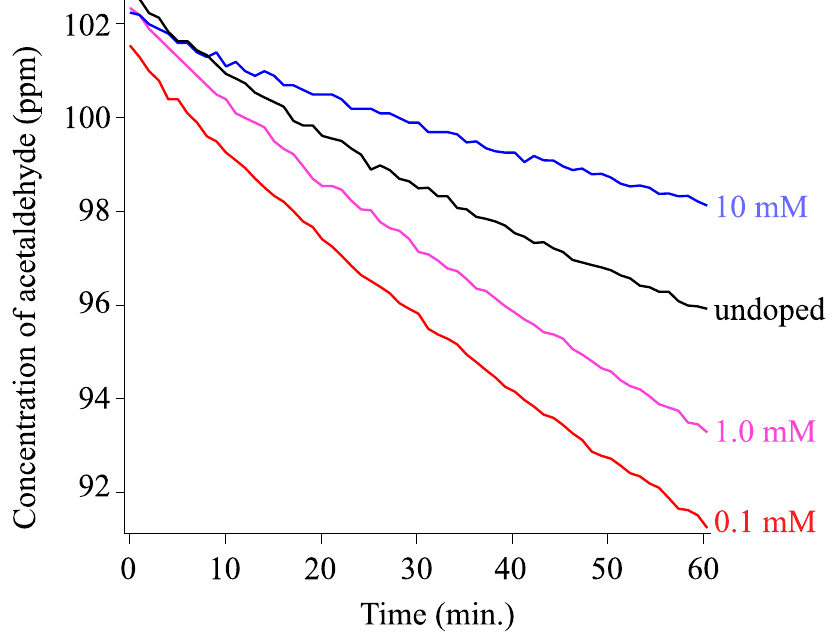
Figure 14. Photocatalytic decomposition of acetaldehyde by undoped (black) and Cu doped TiO 2 (colors) coated on a glass substrate. Red, pink, and blue curves denote 0.1, 1.0, and 10.0 mM Cu nitrate used for synthesis, respectively. Table 3. Average rate constant for undoped TiO 2 and Cu-TiO 2 .